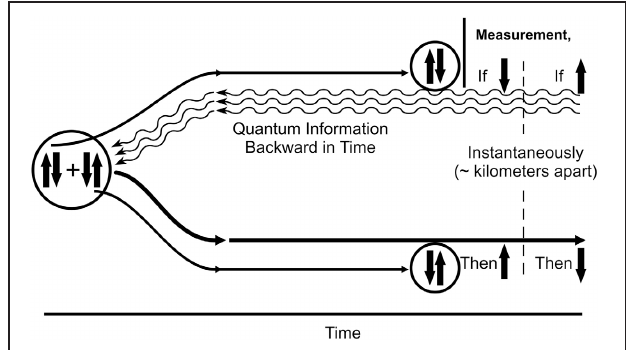
FIGURE 11 | Backward time in EPR entanglement. The Einstein-Podolsky-Rosen (EPR) experiment verified by Aspect et al. (1982); Tittel et al. (1998), and many others. On the left is an isolated, entangled pair of superpositioned complementary quantum particles, e.g., two electrons in spin up and spin down states. The pair is separated and sent to two different, spatially-separated locations/measuring devices. The single electron at the top (in superposition of both spin up and spin down states) is measured, and reduces to a single classical state (e.g., spin down). Instantaneously its spatially-separated twin reduces to the complementary state of spin up (or vice versa). The effect is instantaneous over significant distance, hence appears to be transmitted faster than the speed of light. According to Penrose (2004; cf. Bennett and Wiesner, 1992), measurement/reduction of the electron at the top sends quantum information backward in time to the origin of the unified entanglement, then onward to the twin electron. No other reasonable explanation has been put forth.